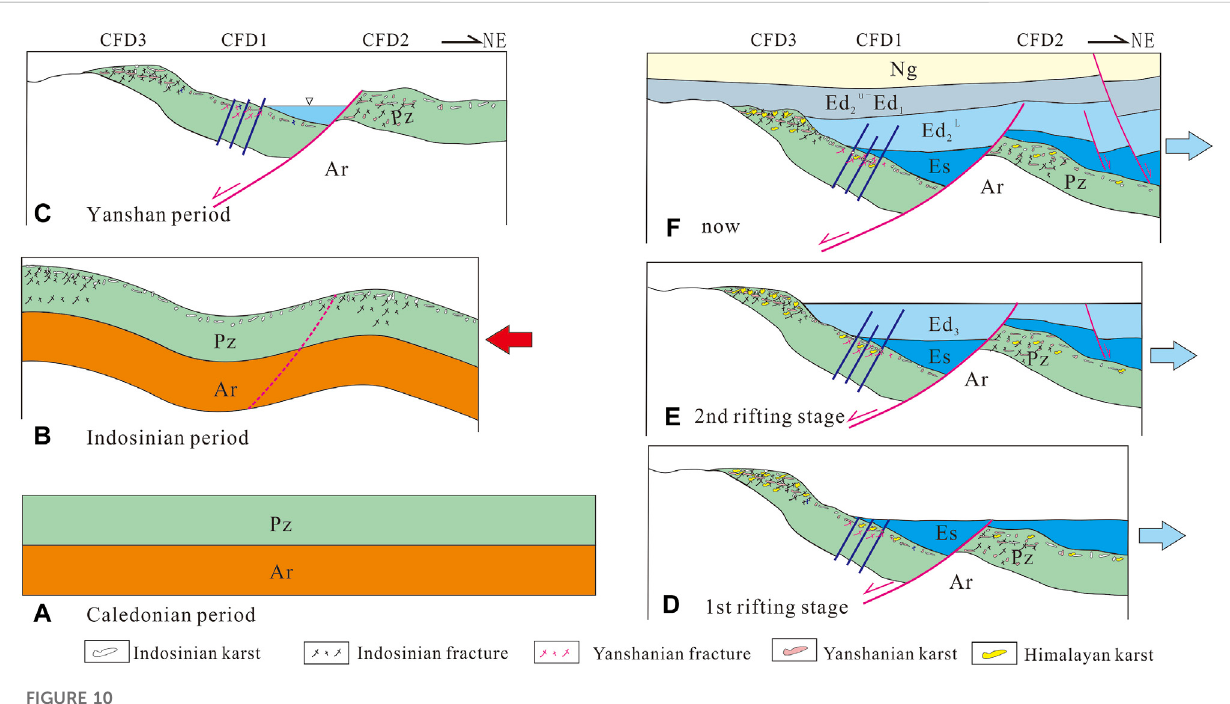
FIGURE 10 (A) : The stable tectonic setting during the pre-Indosinian period; (B) The fracturing and exposed dissolution during the Indosinian thrust folding process; (C) The fracturing and exposed dissolution during the Yanshan strike-slip activity; (D,E) Differential burial and dissolution process during the Paleogene ; (F) Deep bury during the Neogene.